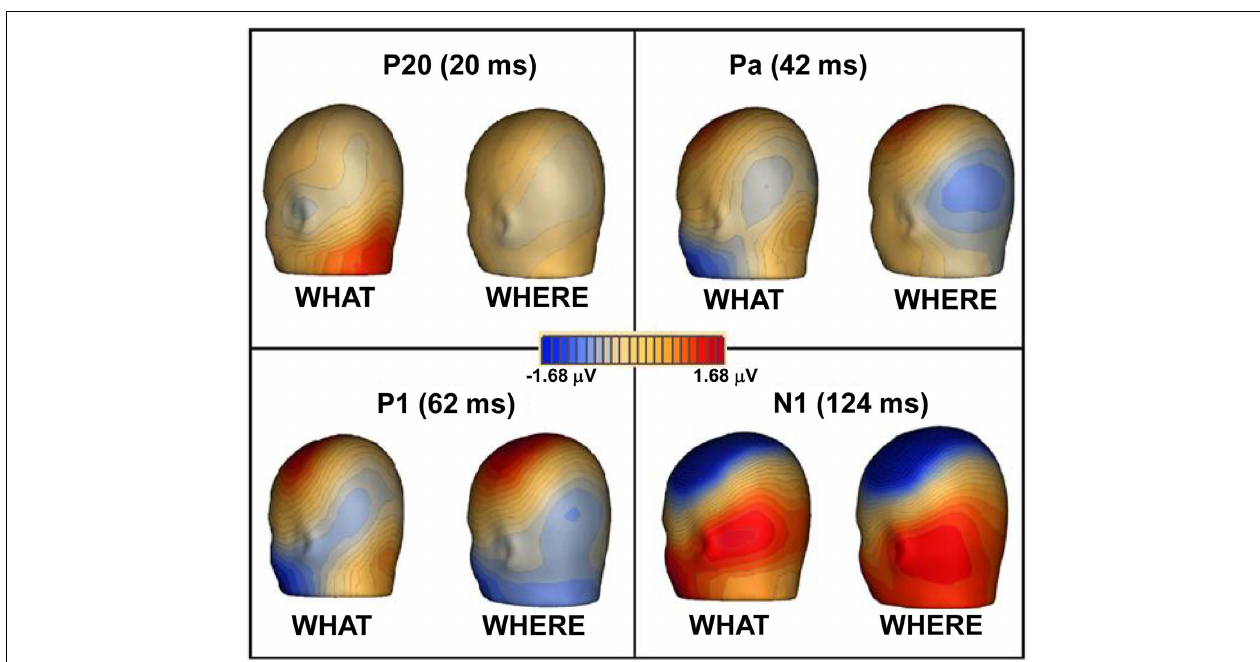
FIGURE 6 |Topographic maps of ERPs recorded during WHAT and WHERE tasks. Group - averaged data are displayed for peak of each auditory component: P20, Pa, P1, and N1.